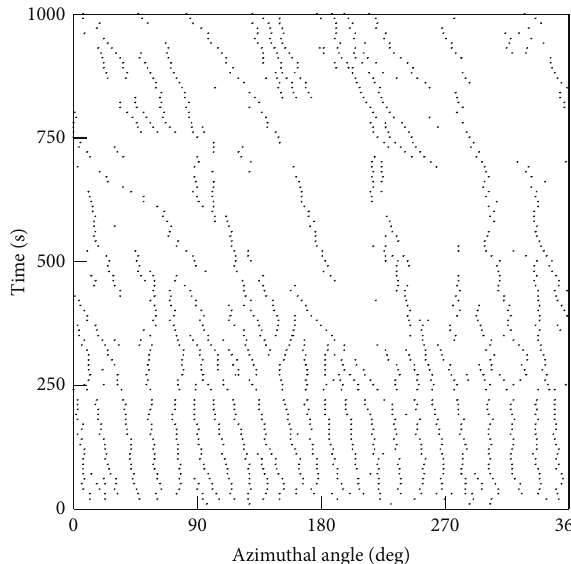
Figure 8: Spatiotemporal evolution of sinusoidal ripples: 𝑞 = 0.262 , ] = 1.3 cSt, 𝑚 = 250 g, and Ω = 36.4 s −1 ; dots illustrate the positions of ripple peaks. Azimuthal angle decreases in the direction of the cylinder